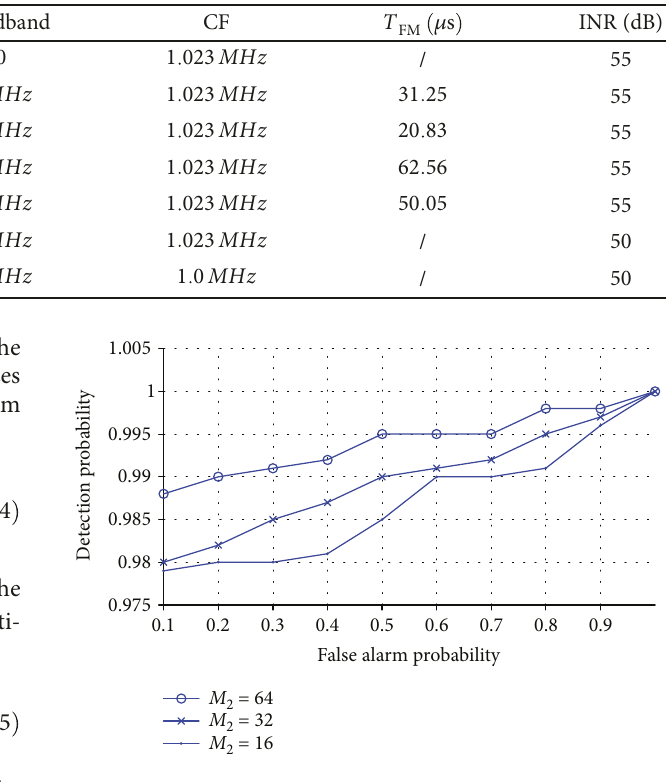
Figure 3: ROC curves of di ff erent M